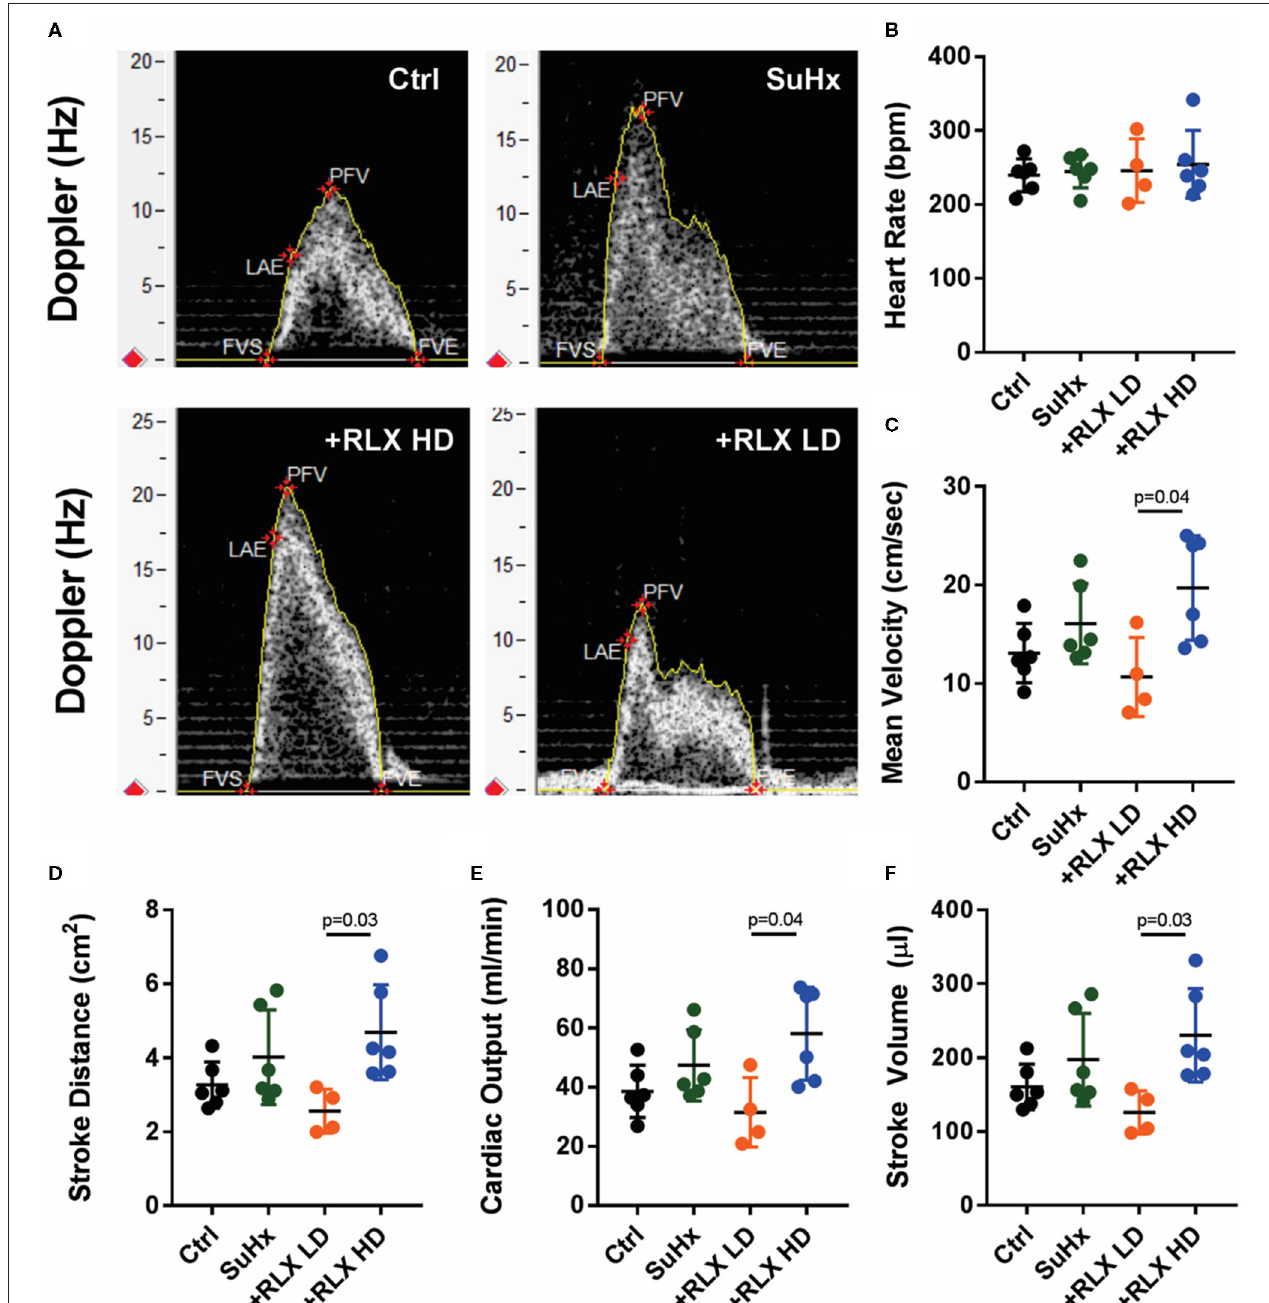
FIGURE 2 | Relaxin significantly altered Doppler flow patterns. (A) Doppler flow velocities from the RV outflow-track exhibited marked mid-systolic notching (indicative of decreased pulmonary compliance) and an increase in PFV in SuHx compared to control (Ctrl) rats [ (A) top panels]. SuHx + low-dose of RLX (RLX-LD) prevented the increase in PFV but did not alter the notching (bottom right panel). High-dose of RLX (RLX-HD) prevented the notching but not PFV (bottom left panel). PAH (SuHx) rats had no significant changes in (B) heart rate, and a tendency to increases in (C) mean Velocity, (D) Stroke Distance, (E) Cardiac Output and (F) Stroke Volume compared to controls. RLX-LD had a tendency to prevent the increase in these parameters caused by SuHx (D–F) but these reductions did not reach statistical significance. RLX-HD was less effective at preventing the higher mean velocity, stroke distance, cardiac output and stroke volume in SuHx compared to RLX-LD.